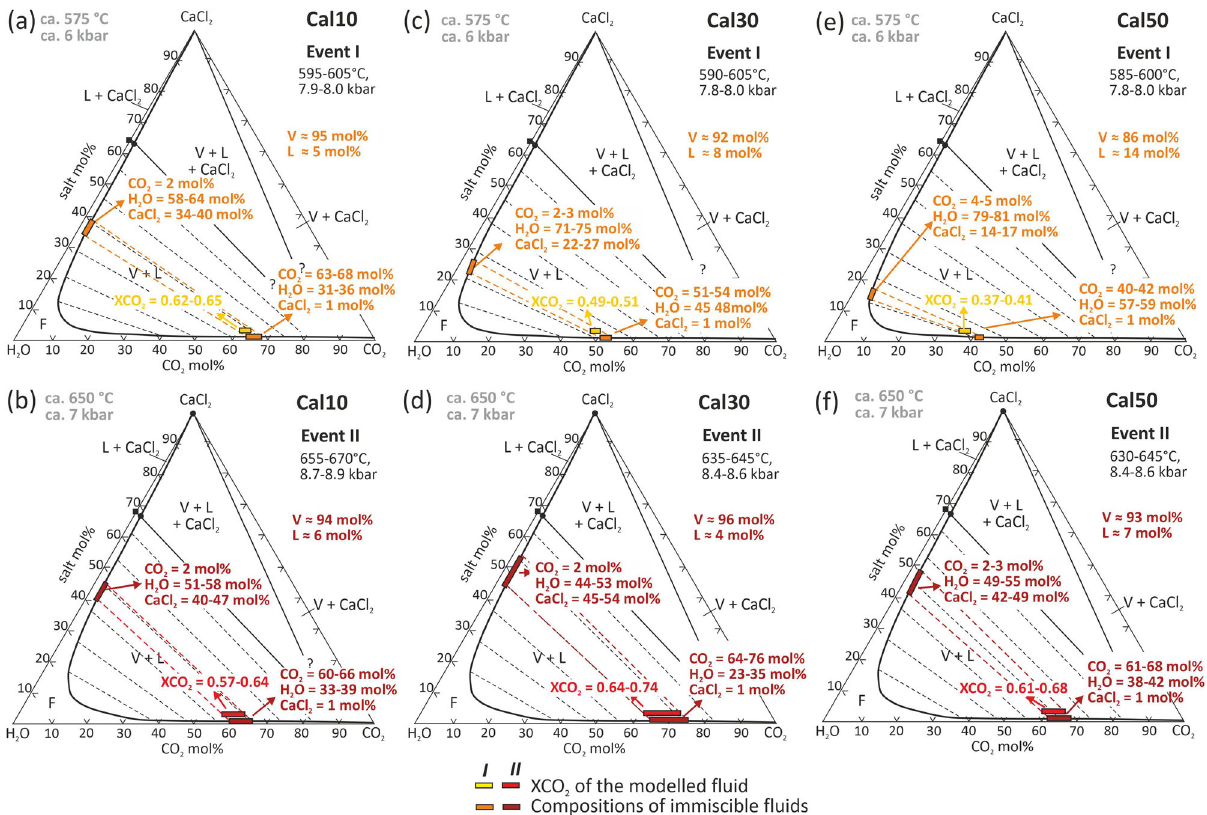
Fig. 4 Phase equilibria in the H 2 O – CO 2 – CaCl 2 system. Phase equilibria in the H 2 O – CO 2 – CaCl 2 system at ca. 575 °C, 5 kbar and at ca. 650 °C, 7 kbar (interpolated from experimental data by ref. 69 ), showing phase relations for fl uids generated by the modeled sediments ( a , b Cal10; c , d Cal30; e , f Cal50) at the event I ( a , c , e ) and event II ( b , d , f ), in the hypothesis of salinity of 10 wt% CaCl 2 (corresponding to CaCl 2 ≈ 3 – 4 mol%). Dashed lines outline the V – L tie-lines within the two-phase fi elds. Fluids released during events I and II systematically plot within the solvus . Two immiscible fl uids thus coexist at every P – T conditions: a CO 2 -rich vapor and a hydrosaline brine (boxes on the solvus ). F one-phase fl uid, V vapor, L liquid. Phase relations for Cal70 are reported in Supplementary Fig. S1c, d. Table 2 Compositional ranges (mol%) of immiscible fl uids generated by each modeled bulk composition (Cal10, Cal30, Cal50, Cal70) during event I and event II in the H 2 O – CO 2 – NaCl